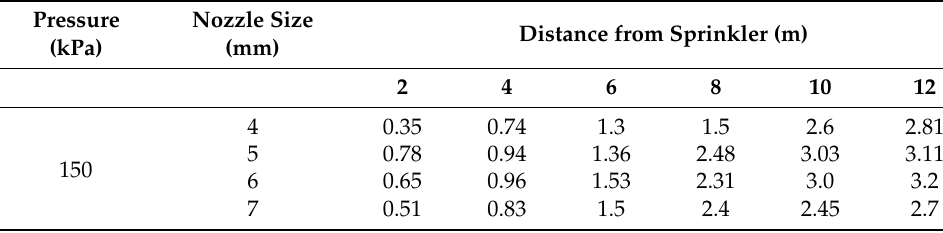
Table 1. Arithmetic mean droplet size diameter (mm) for different nozzle sizes and operating